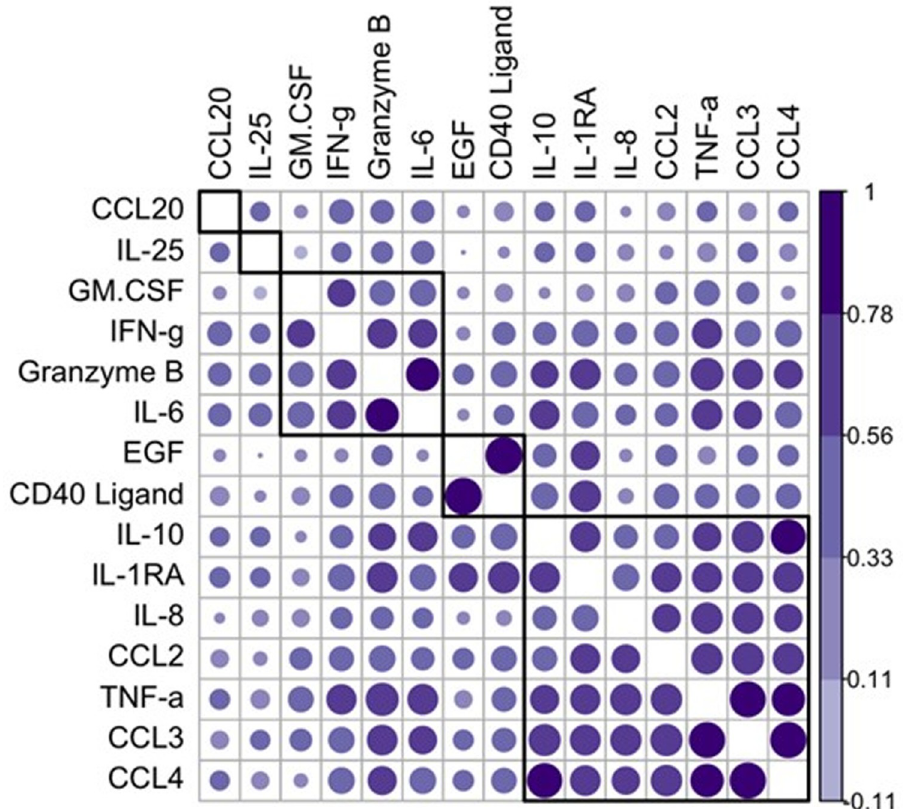
Fig 6. Correlations of cytokines that significantly change between the pre-infusion and post-infusion blood draws pearson’s correlation between cytokine pairs is indicated by color and size of dots. The larger and deeper colored dots indicate a higher r value. The analytes were hierarchically clustered, and the black boxes correspond to clusters generated at a level of 6 clusters.